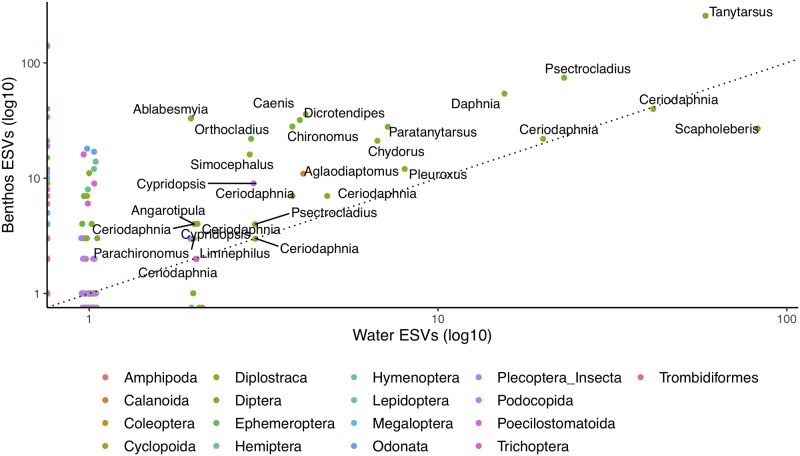
A greater diversity of arthropod sequence variants are detected from benthic samples.Each point represents a genus identified with high confidence and the number of benthic and water exact sequence variants (ESVs) with this taxonomic assignment. Only genera represented by at least 2 ESVs in both benthic and water samples are labelled in the plot for clarity. The points are color coded for the 17 arthropod orders detected in this study. A 1:1 correspondence line (dotted) is also shown. Points that fall above this line are represented by a greater number of ESVs from benthic samples. A log10 scale is shown on each axis to improve the spread of points with small values.